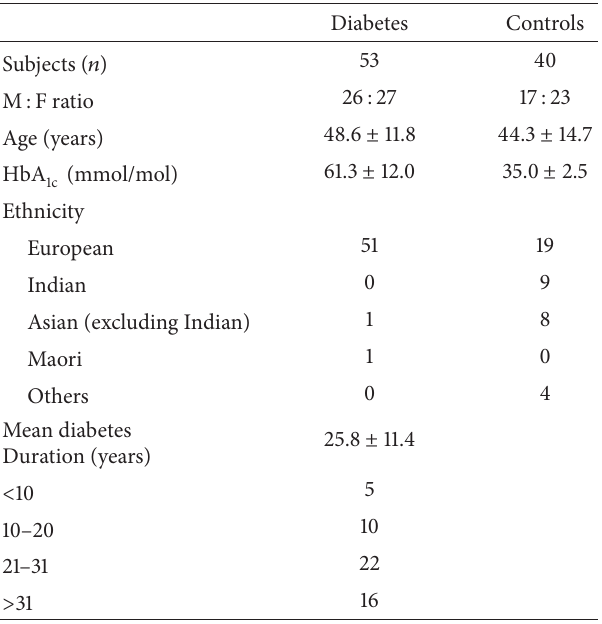
Table 1: Participant characteristics for the patients with type 1 diabetes and control